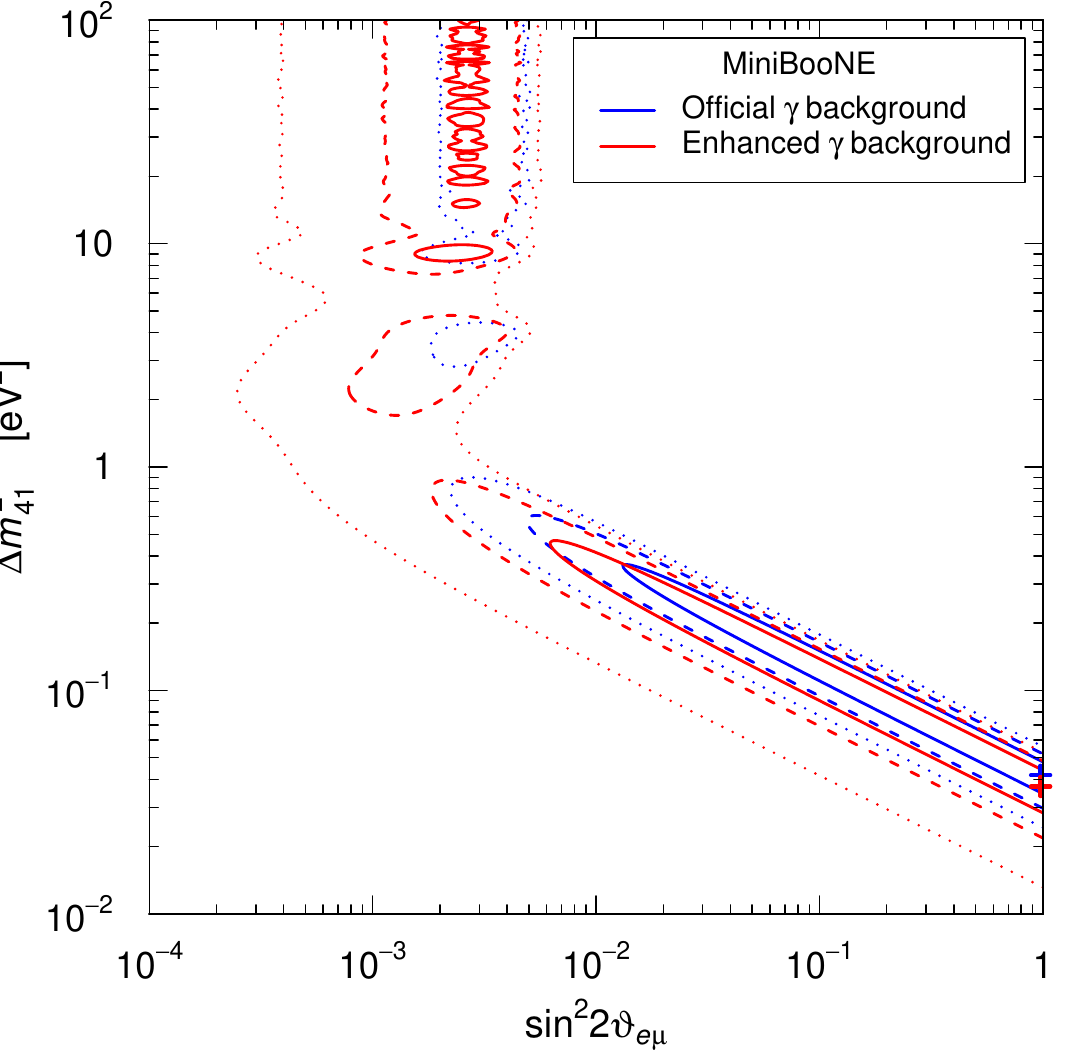
Figure 2 . Contours enclosing 1 σ (solid), 2 σ (dashed), and 3 σ (dotted) allowed regions in the ( sin 2 2 ϑ eµ , ∆ m 2 ) plane obtained from the analysis of MiniBooNE data without (blue) and with 41 (red) our single- γ background